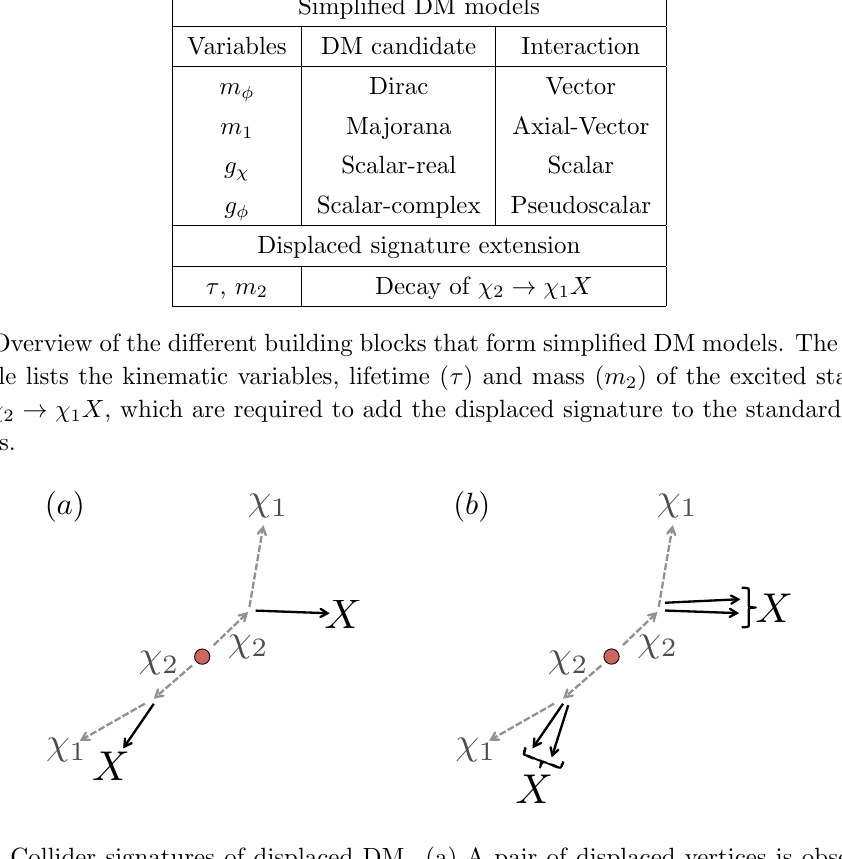
Figure 1 . Collider signatures of displaced DM. (a) A pair of displaced vertices is observed with a single state X produced at each vertex. (b) A pair of displaced vertices is observed with a collection of states X produced at each vertex. In both cases the DM will typically carry away missing transverse energy, which is a smoking gun for displaced DM